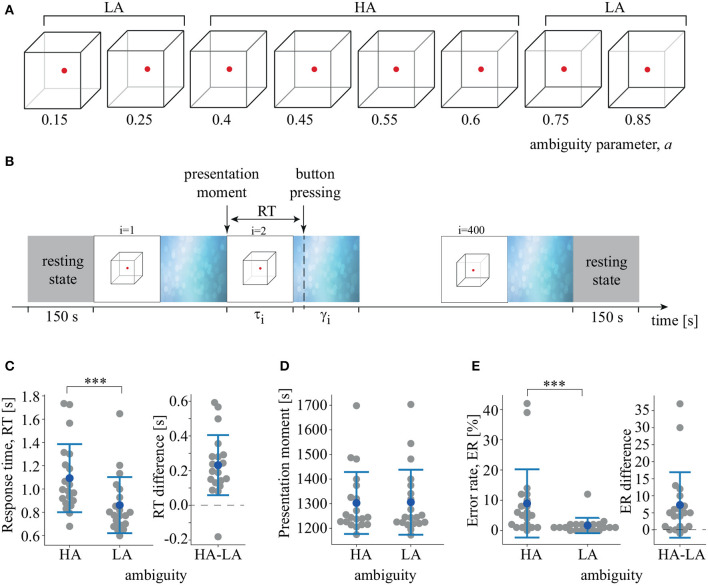
(A) Set of visual stimuli, Necker cubes, with different degrees of ambiguity, a. (B) Schematic illustration of the experimental sessions. τi is the duration of i-th stimulus presentation, γi is the time of the abstract image presentation between i-th and (i + 1)-th stimuli. RT is the response time. (C) RT to LA and HA stimuli and distribution of the pairwise differences (***p < 0.001, t-test). (D) Median presentation times of LA and HA stimuli. (E) Error-rate (ER) of LA and HA stimulus processing and distribution of the pairwise differences (***p < 0.001, Wilcoxon test). Group data are shown as means±SD and individual values.